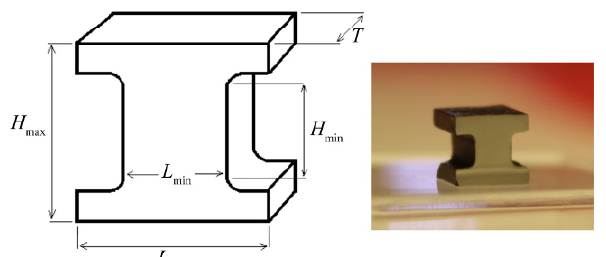
Fig. 1 I-shaped specimen dimensions (left). Snapshot of the specimen after 10% creep strain (right).